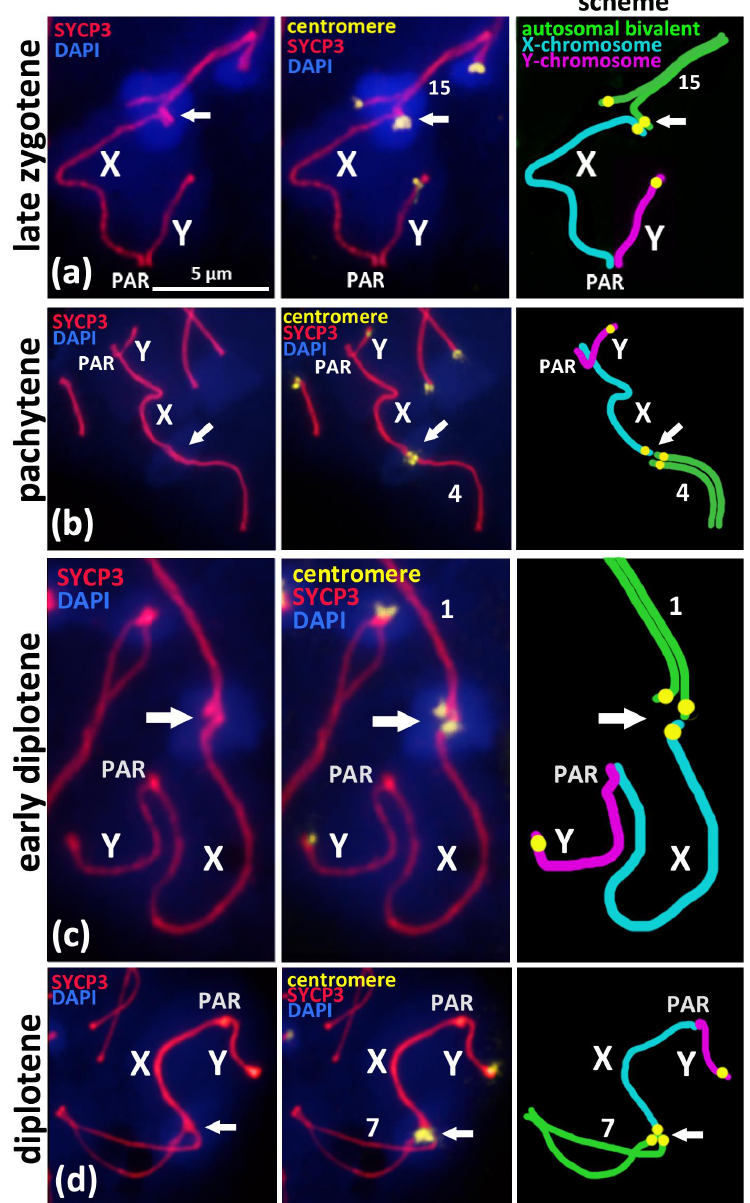
Figure 2. Associations of X chromosome with different autosomal bivalents on the successive stages 2 of meiotic prophase I in BALB/c mouse. Chromatin was stained with DAPI (blue), axial elements of meiotic chromosomes were immunostained with the antibodies against the SYCP3 protein (red), and centromeres were stained with the ACA antibodies (yellow). Pseudoautosomal region of sex bivalent is indicated “PAR”. ( a )—Late zygotene, short synaptonemal complex (white arrow) assembled “side- by-side” between the pericentromeric regions of the autosomal univalent 15 and the X chromosome. ( b )—Pachytene, “end-to-end” association of autosomal bivalent 4 and the X chromosome after its competitive replacement from the non-homologous SC-assembly. ( c )—Early diplotene, “end-to- end” association of the X chromosome and autosomal bivalent 1. ( d )—Mid-diplotene, “end-to-end” association of the X chromosome and autosomal bivalent